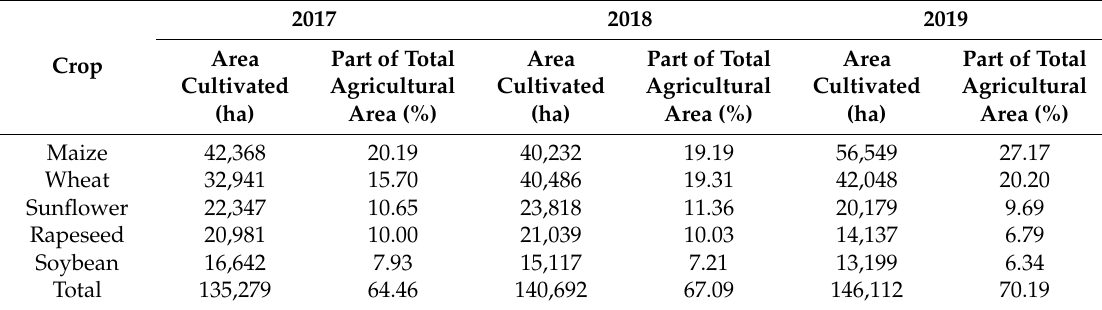
Table 1. Annual crop coverage statistics of five major crops in the Osijek-Baranja